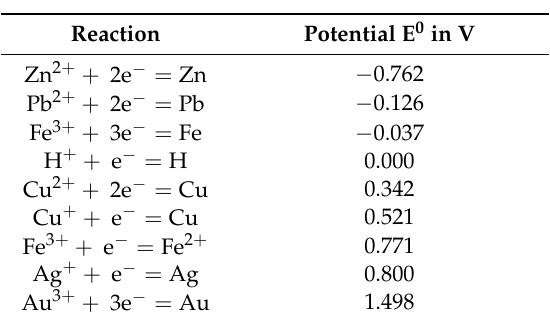
Table 3. Electrochemical potential of selected